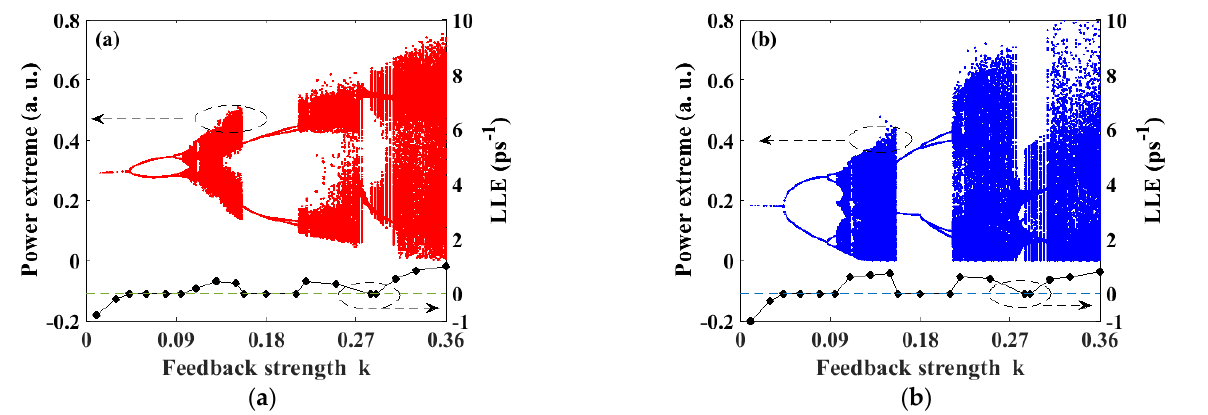
Figure 4. Bifurcation diagrams of power extreme and largest Lyapunov exponent (LLE) as a function of feedback strength of the GS lasing ( a ) and ES lasing ( b ) in a TSQDL biased at 120 mA under optical feedback with τ = 100 ps.